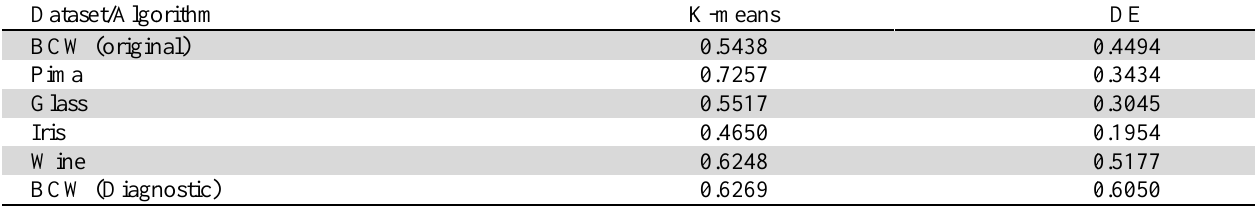
The results Dataset/Algo BCW (origin